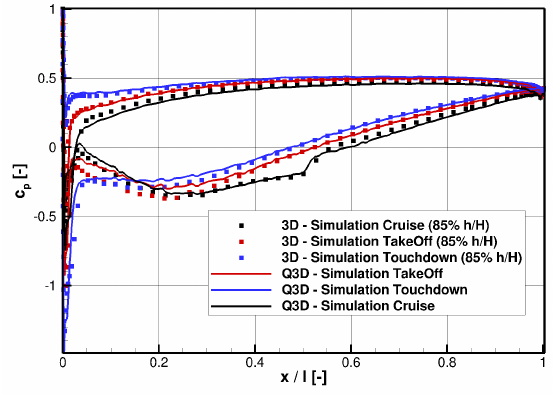
Figure 2. Non-dimensional surface pressure distribution c p for three operating points at 85% blade height. Q3D: